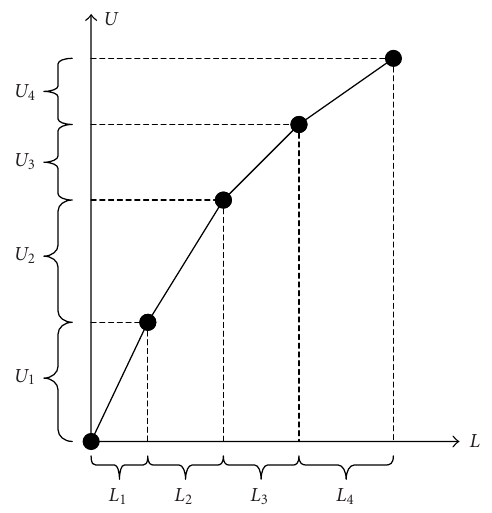
Figure 4: Example of convex utility-length characteristic for a scal- able source consisting of four elements with a simple chain of de-